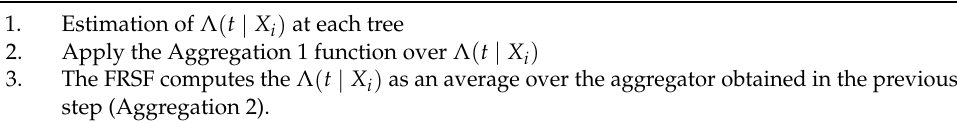
Table 3. Algorithm FRSF—Ensemble.